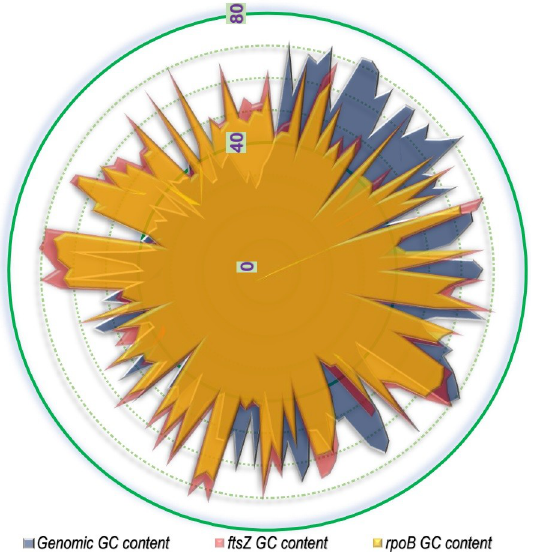
Fig 1. A superimposed radar plot comparing the genomic GC content with that of the ftsZ and rpoB CDS GC content of the 143 bacterial species considered in this study. From the centre to the periphery each concentric ring represent increase in 10% GC